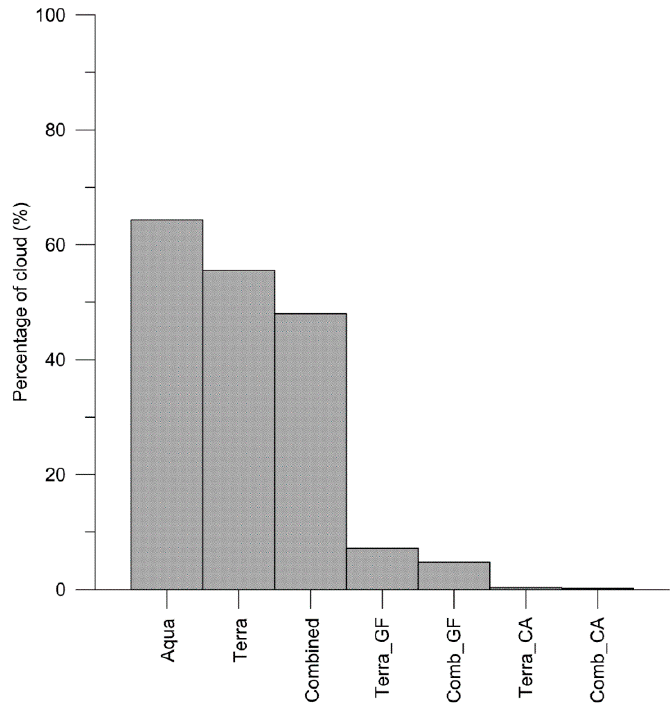
Figure 5. Changes in percent of cloud coverage after a series of cloud reduction steps applied to daily MODIS snow products Aqua and Terra; Combined—The combination of both satellites; Terra_GF—Gap-filling applied to only Terra; Comb_GF—Gap-filling applied to the combination; Terra_CA— Conditional adjustment applied to Terra_GF; Comb_CA—Conditional adjustment applied to Comb_GF.